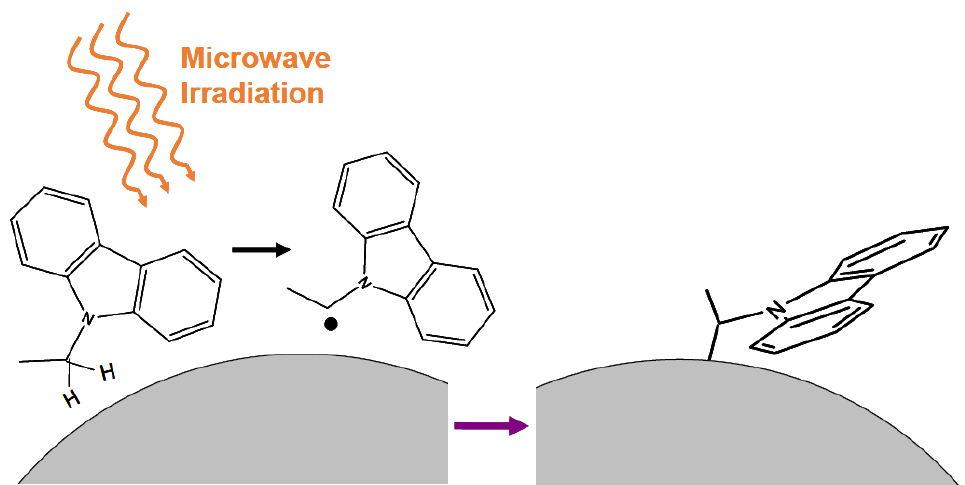
Figure 2. The reaction scheme on the selectively and rapidly heated small carbon nanoparticle enabling the hydrogen abstraction to generate NEC radical on the nanoparticle surface for the in situ addition.